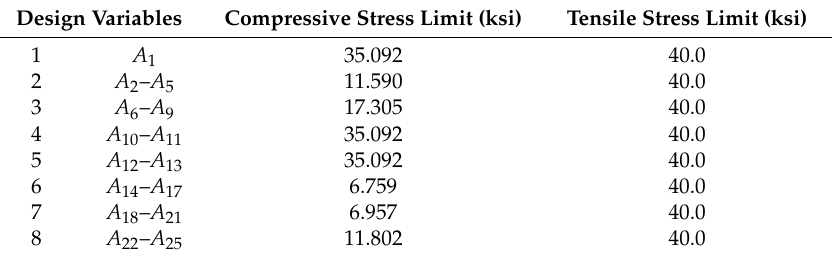
Table 4. Loading conditions acting on the 25-bar truss.